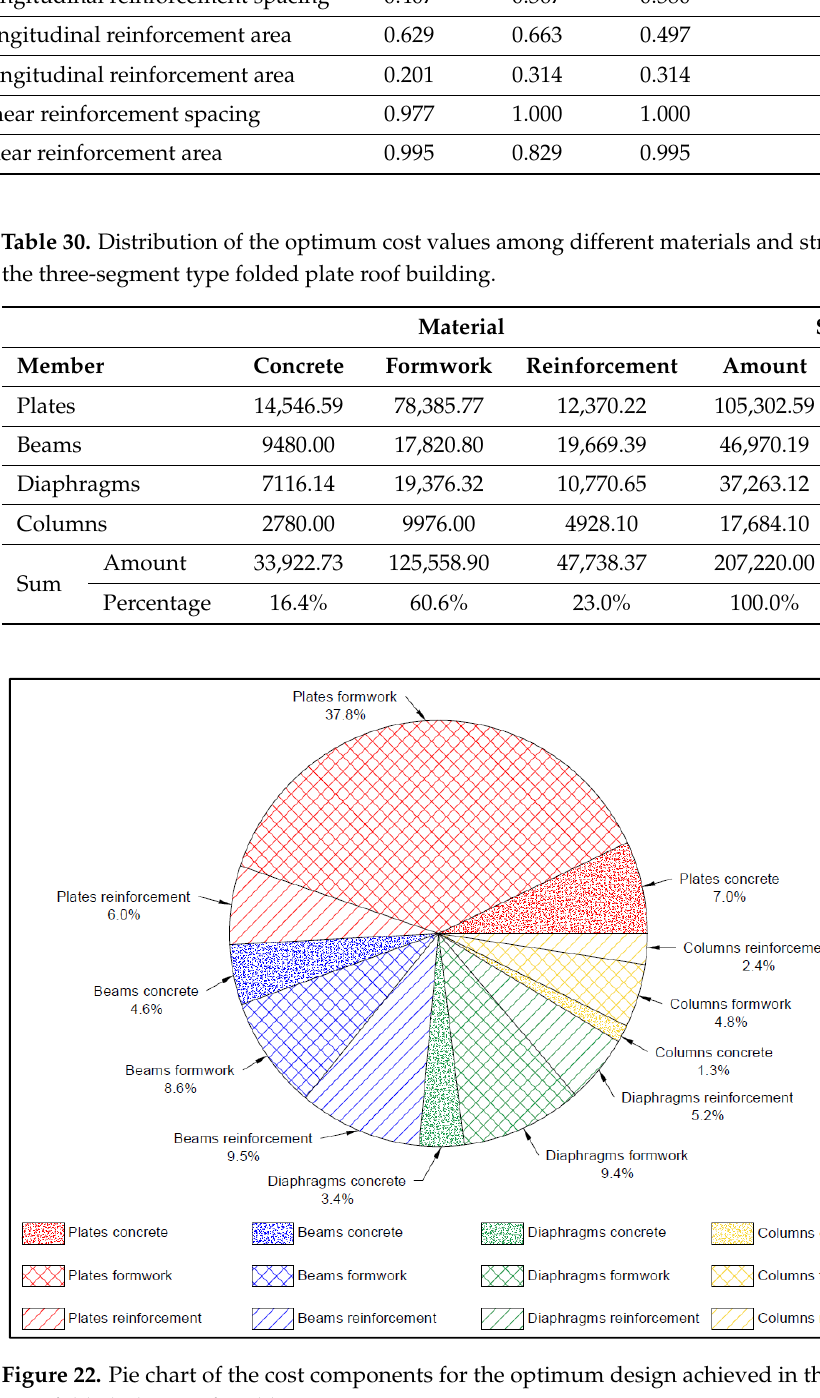
Figure 22. Pie chart of the cost components for the optimum design achieved in the three-segment type folded plate roof